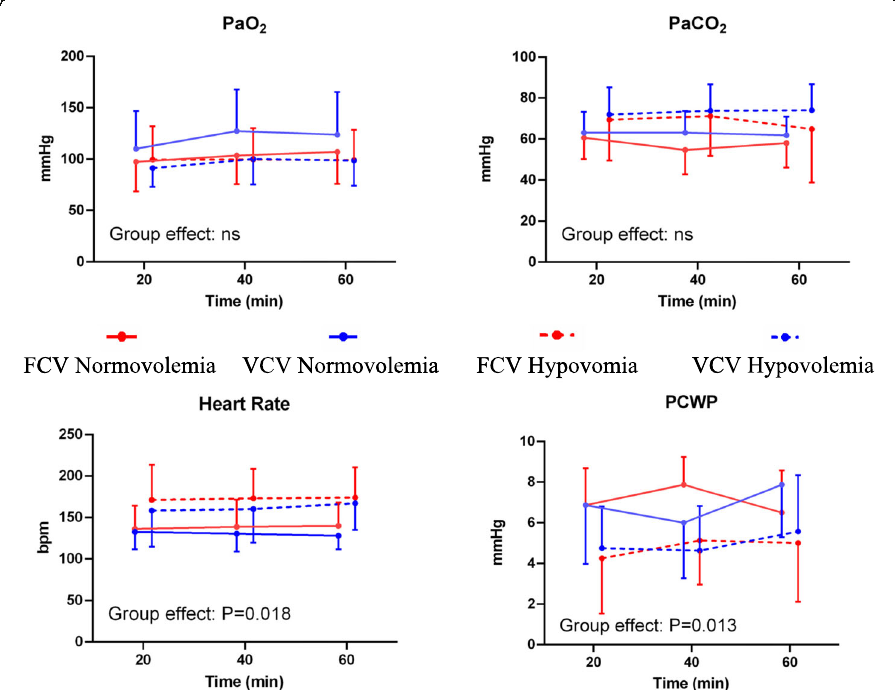
Fig. 2 Gas exchange and haemodynamics. Symbols and vertical lines represent mean and standard deviation. Global statistical significance was accepted at P < 0.05. Differences between the two groups and the two ventilation strategies were compared using linear mixed-effects, repeated measures ANOVA. FCV = flow-controlled ventilation; VCV = volume-controlled ventilation; ns = not significant, PaO 2 = arterial oxygen pressure; PaCO 2 = arterial carbon dioxide pressure; PCWP = pulmonary capillary wedge